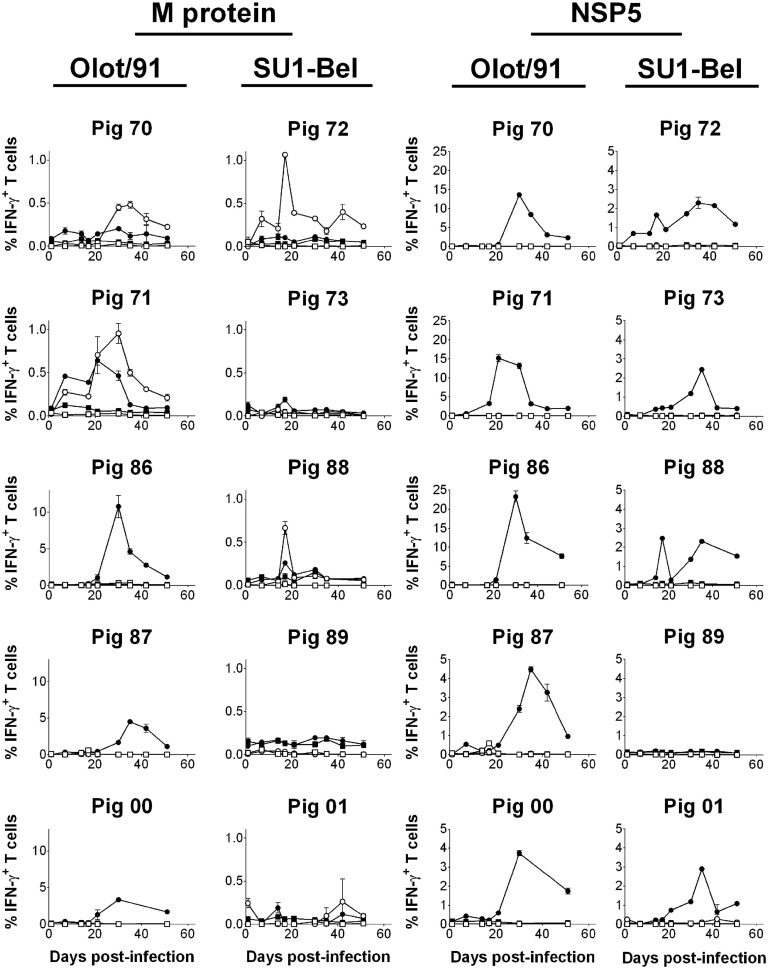
Assessment of NSP5- and M-specific IFN–γ T cell responses over the course of infection and challenge with PRRSV-1 Olot/91 and SU1-Bel strains. Previously cryopreserved PBMC were stimulated ex vivo with synthetic peptide pools representing M or NSP5 protein or left unstimulated. IFN-γ expression by CD4+CD8αlow (CD4; open symbols) and CD4−CD8αhigh (CD8; closed symbols) T cells from unstimulated (square symbols) or peptide pool-stimulated cultures (circle symbols) was assessed by flow cytometry. The mean % of IFN-γ+ T cells from duplicate cultures are presented for each animal and error bars show the SEM. Data from peptide pool-stimulated cultures were compared against the corresponding unstimulated culture using a two-way ANOVA followed by a Tukey’s multiple comparison test.